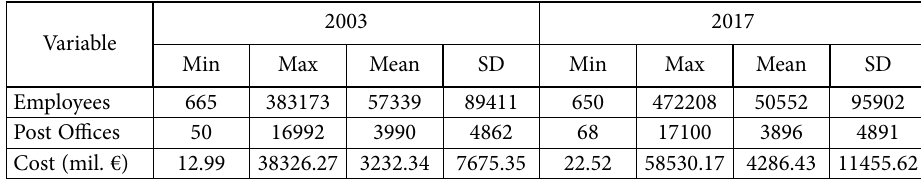
Table 1. Average descriptive statistics for input variables (source: calculated by the authors based on data from Universal Postal Union (2019)) Variable